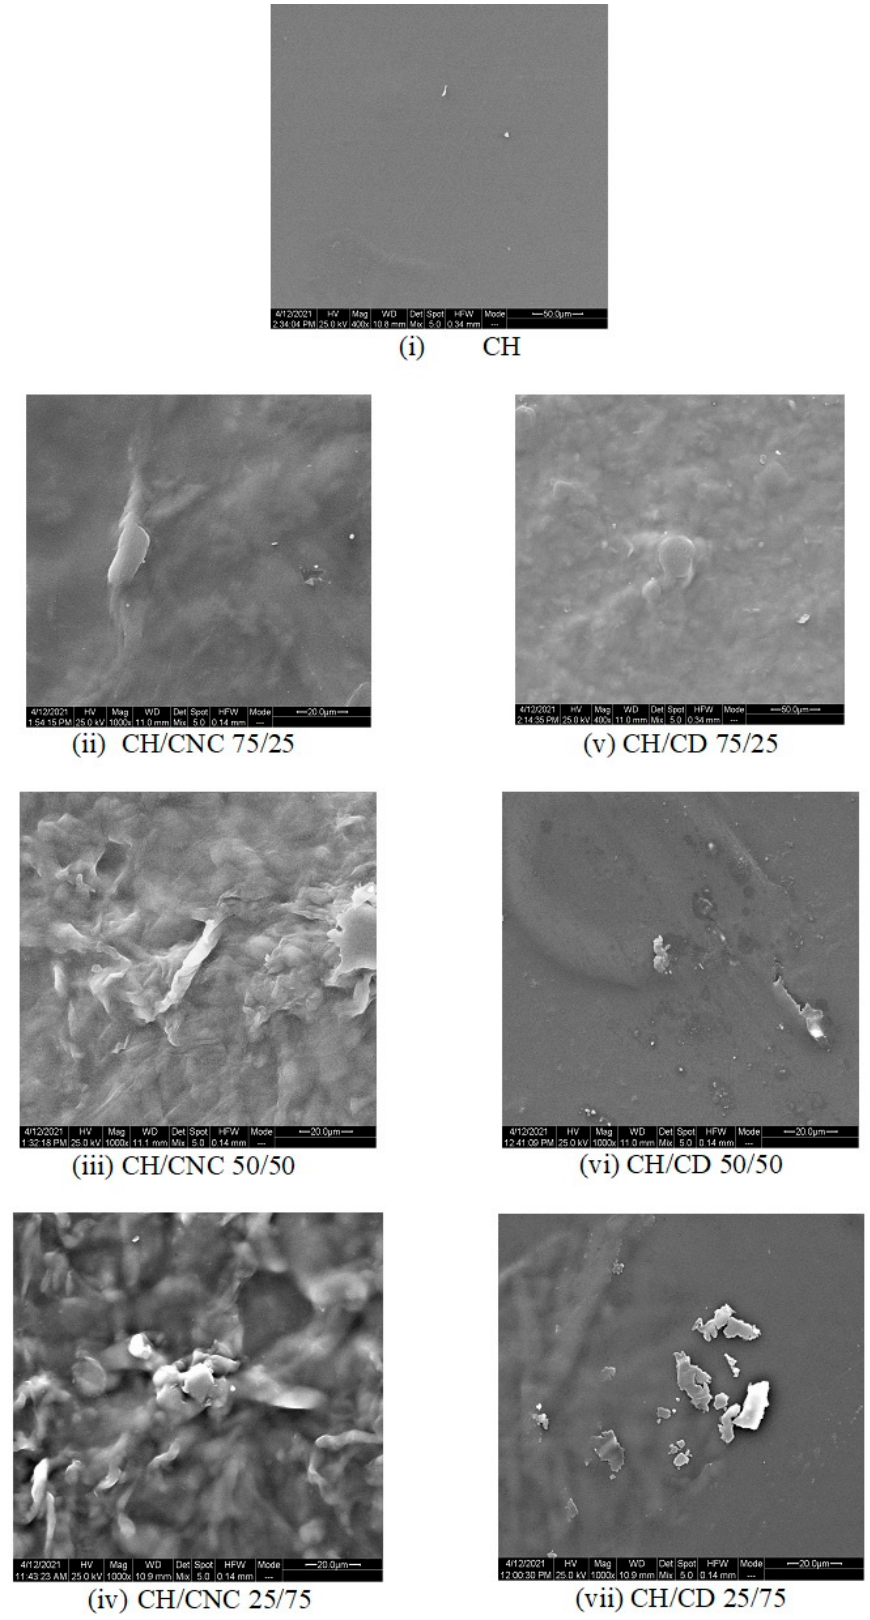
Figure 2. SEM images of the surface of different CH, CH/CNC and CH/CD edible films.